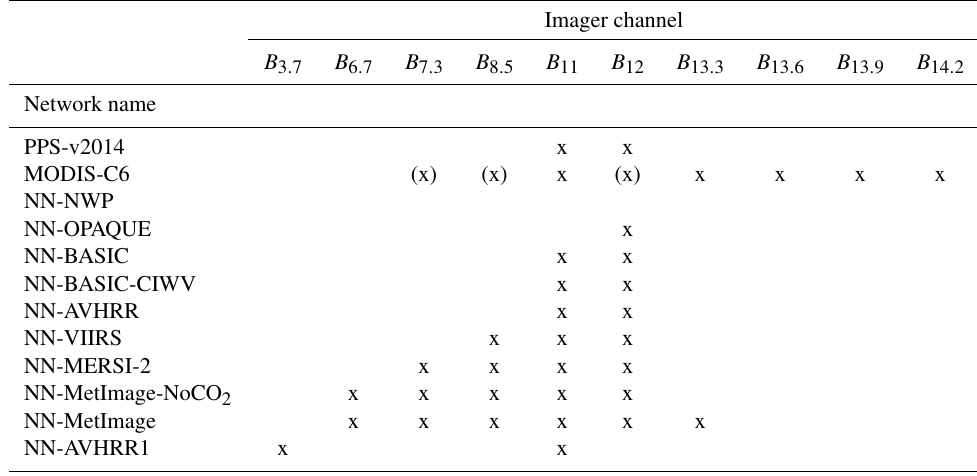
Table 4. Description of the imager channels used for the different algorithms. For MODIS-C6 channels used indirectly, to determine if CO 2 -slicing should be applied, are noted with